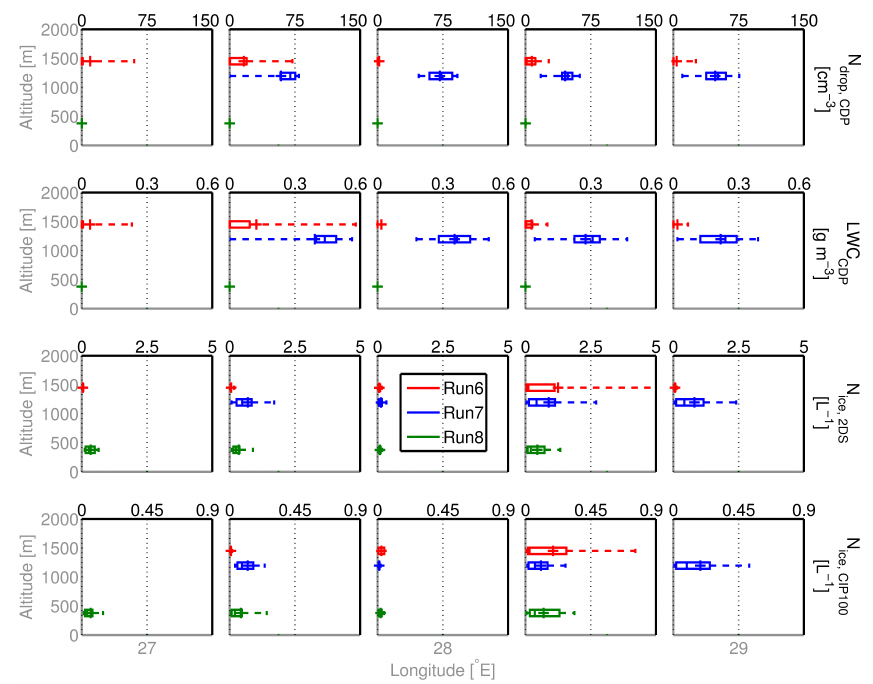
Figure 10. Percentile plots of CDP droplet number concentration (first row), CDP liquid water content (second row), 2DS ice number concentration (third row), and CIP100 ice number concentration (fourth row) measured over the ocean. As in Fig. 7, columns represent different longitude bins and data are coloured by SLR (as shown in the